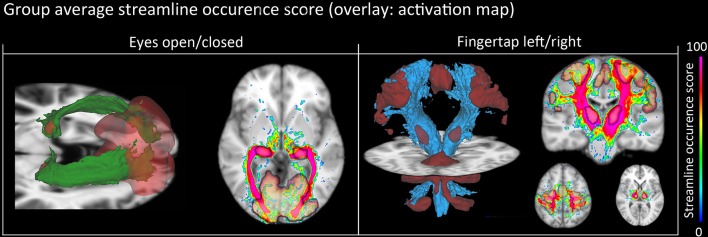
Group-average WM pathway probability. Column 1: 3D isovolumes (green: optic radiation, red: thalamic, and visual-cortex fMRI-derived activation sites). The axial slice shows the color-coded streamline occurrence score along with their respective fMRI activation maps. Column 2: 3D isovolumes (blue: CST, red: motor cortex, thalamus, and cerebellum) showing great correspondence with uncovered fMRI activation sites (motor strip, axial view). Visualization was done using the FiberNavigator (Vaillancourt et al., 2011; Chamberland et al., 2014).